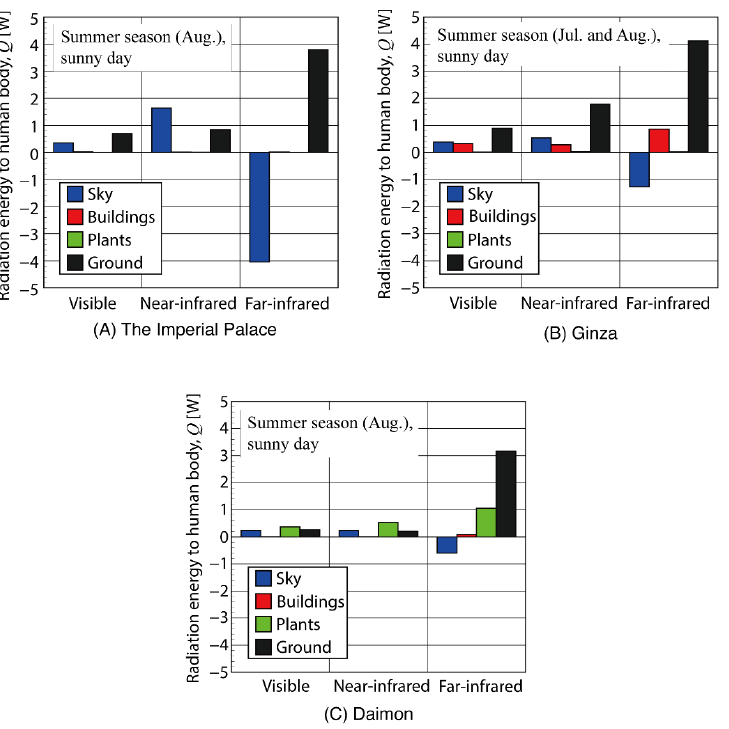
Figure 10. Calculated radiation energy to the human body in summer experiments for each location: ( A ) the Imperial Palace, ( B ) Ginza, and ( C ) Daimon.